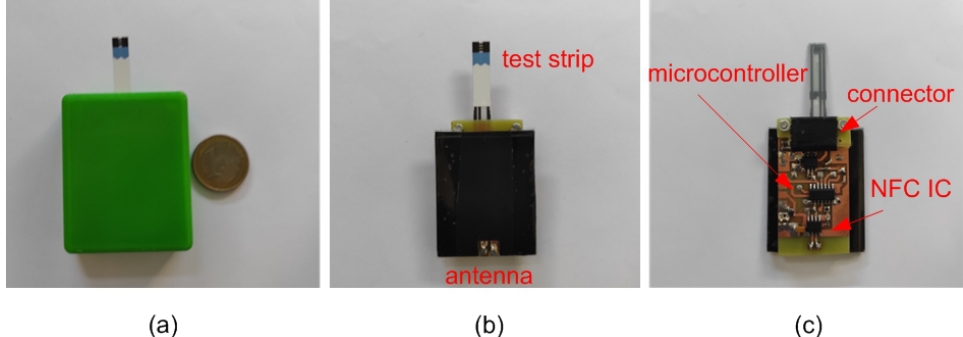
Figure 16. NFC glucometer prototype. ( a ) Prototype including protection case, ( b ) top view, and